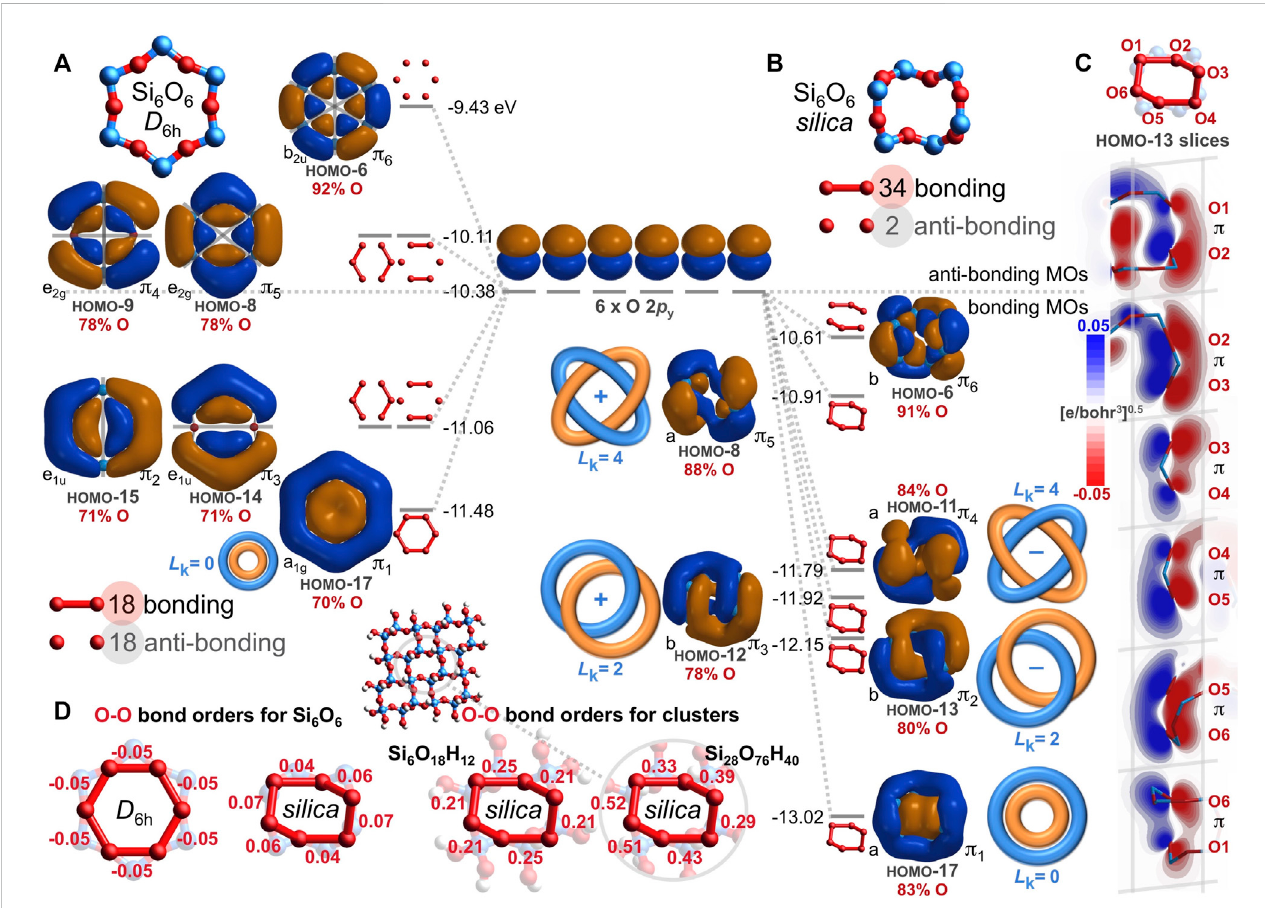
FIGURE 6 Oxygen 2 p y -based valence molecular orbitals (IsoValue = 0.005 [e/bohr 3 ] 0.5 ) for geometry optimized, planar D 6h Si 6 O 6 (A) and for chiral, saddle-shaped Si 6 O 6 foundinquartzsilica (B) .Bondingandanti-bondingO-O interactionsaretabulatedalongwiththeatomic orbitalcontributionsforthesixOatoms(red). Contiguous π molecularorbitalsareclassi fi edaseitherHückel aromatic( L k =0)orMöbiusaromaticwithtwoorfourhalf-twists ( L k =2or4).Obliqueslicesfor the silica Si 6 O 6 HOMO-13 along each O-O axis reveal contiguous O 2 p y – O 2 p y π bonding interactions, resulting in Möbius aromaticity with L k = 2 (C) . Oxygen-oxygen bond orders are negative for planar D 6h Si 6 O 6 but positive for non-planar, silica-based Si 6 O 6 and larger silica clusters (D) .